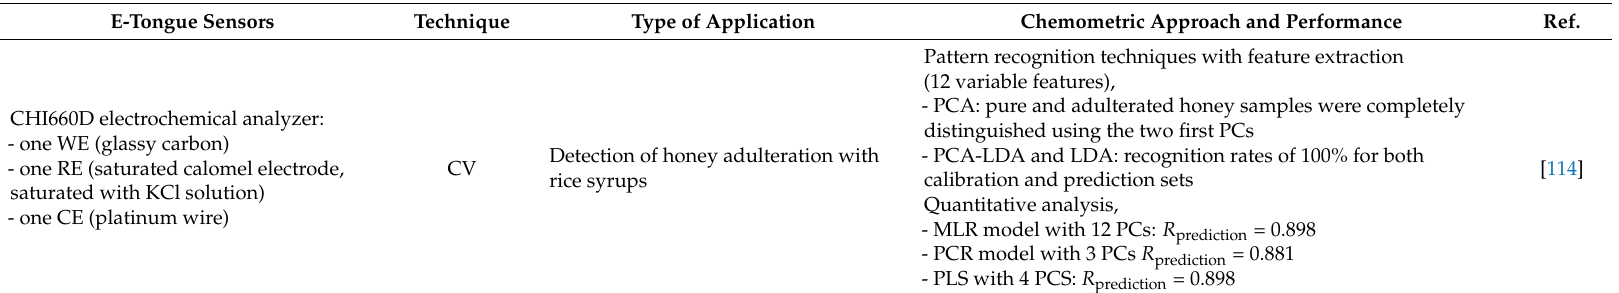
Table 3. Honey evaluation using commercial voltammetric E-tongue based device.